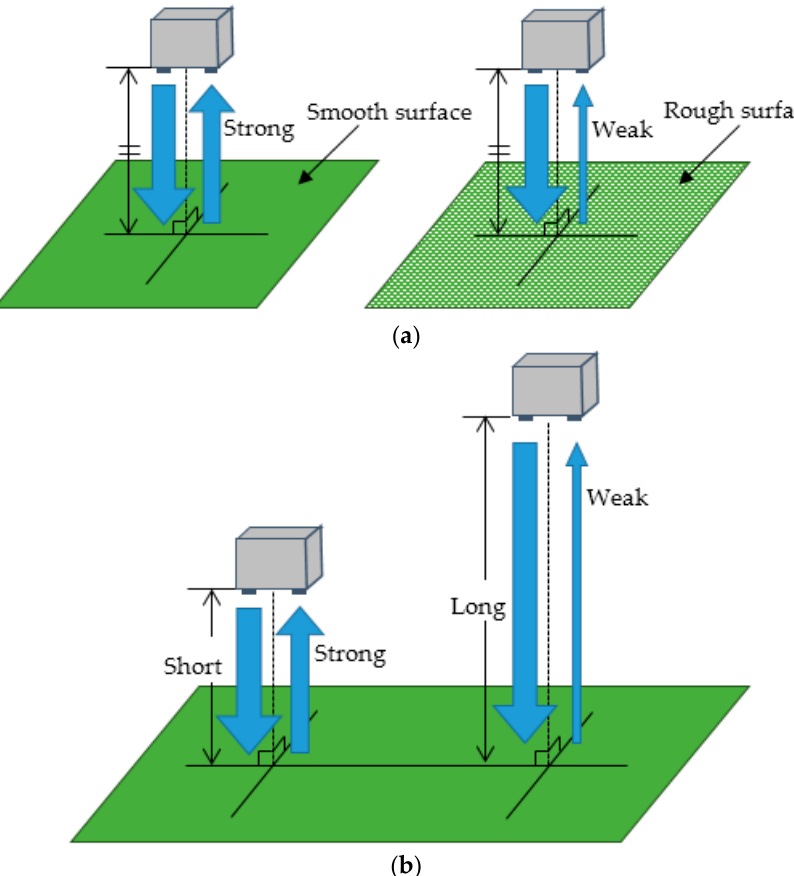
Figure 3. Characteristics of reflection influenced by roughness and detecting distance: ( a ) Difference in reflection intensities by surface roughness; ( b ) Difference in reflection intensities by distance detection.